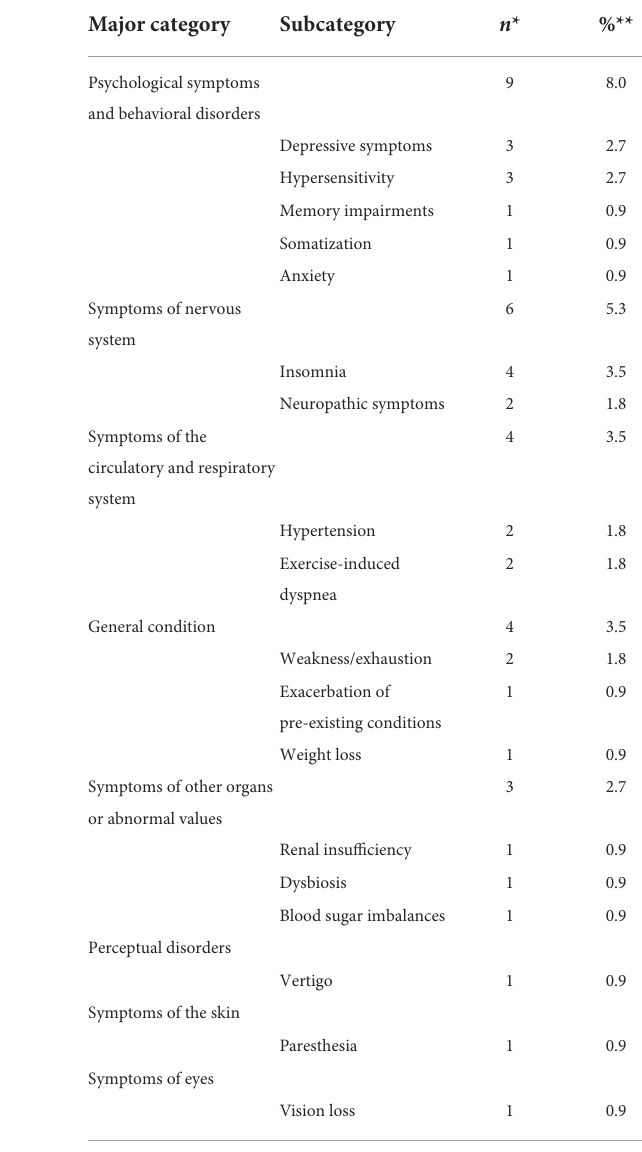
TABLE 4 Additional reported symptoms of patients with long COVID lasting more than 12